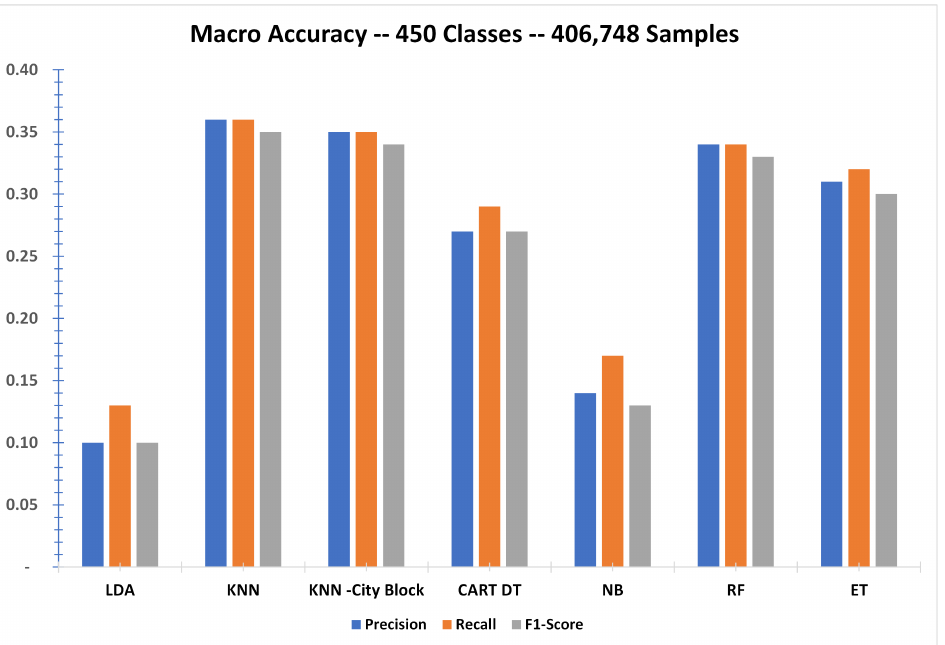
Figure 3. Macro accuracy of the trained